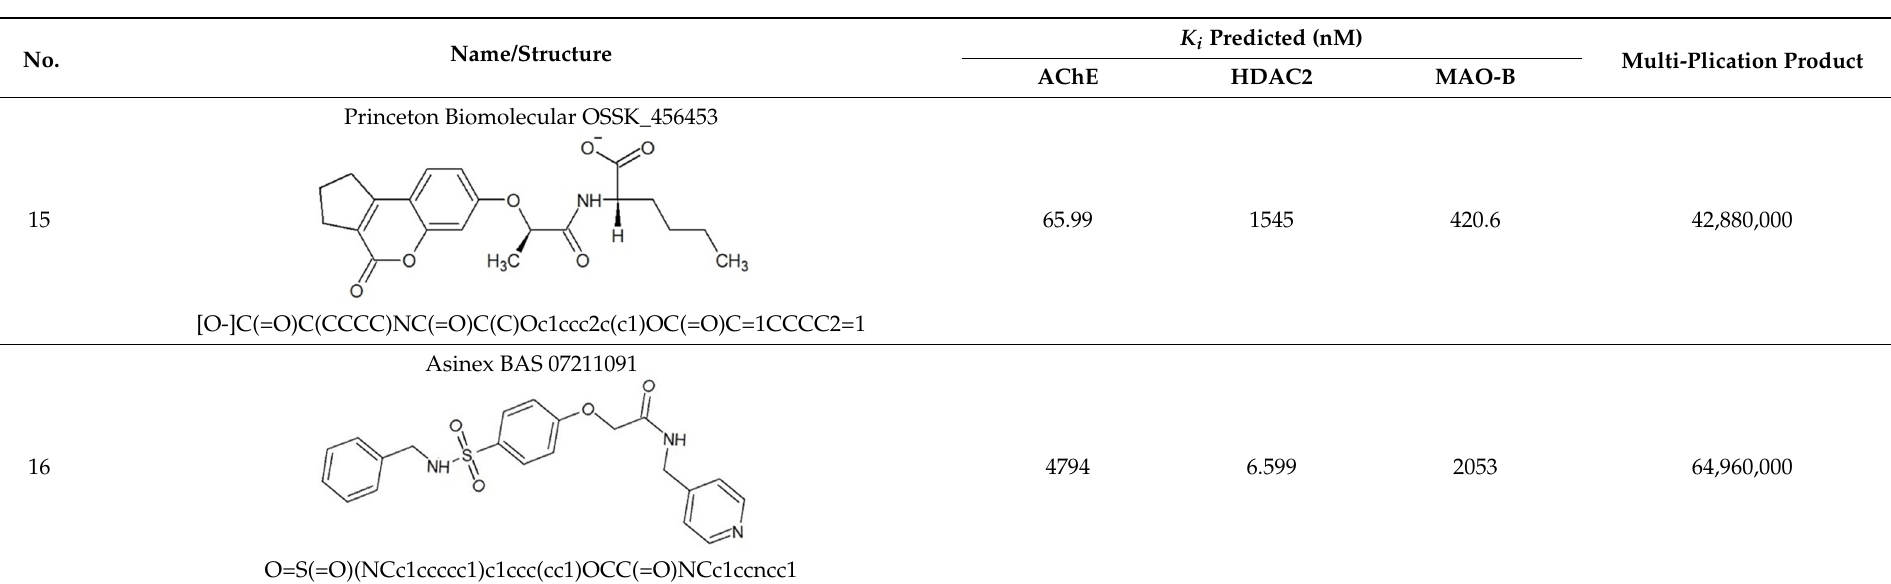
Figure 5. Consensus pharmacophore models of the top 16 hit ligands of AChE, HDAC2, and MAO- B. The following pharmacophoric features are outlined in the models: AChE—F1 (hydrophobic/aromatic feature), F2 (functional groups capable of performing hydrogen bonds (HB)), F3 (functional groups capable of performing HBs as HB acceptors); HDAC2—F1, F2 (hydrophobic/aromatic features), F3, F4 (functional groups capable of performing HBs as HB acceptors), F5 (functional groups capable of performing HBs as HB donors); MAO-B—F1, F2, F3 (hydrophobic/aromatic features).Individually for each protein, the pharmacophore features were present in 11 ligands for MAO-B, 8 for HDAC2 and 7 for AChE. Finally, four ligands contained every single pharmacophore feature for each protein (compounds: Specs AH-487/42478269 (1), Comgenex CGX-3274395 (8), Chem T&I AMCLME-10390 (10), and Asinex BAS 07211091 (16) in Table 3). These compounds were outlined as potential multi-target acting hits and subjected to further analyses as described